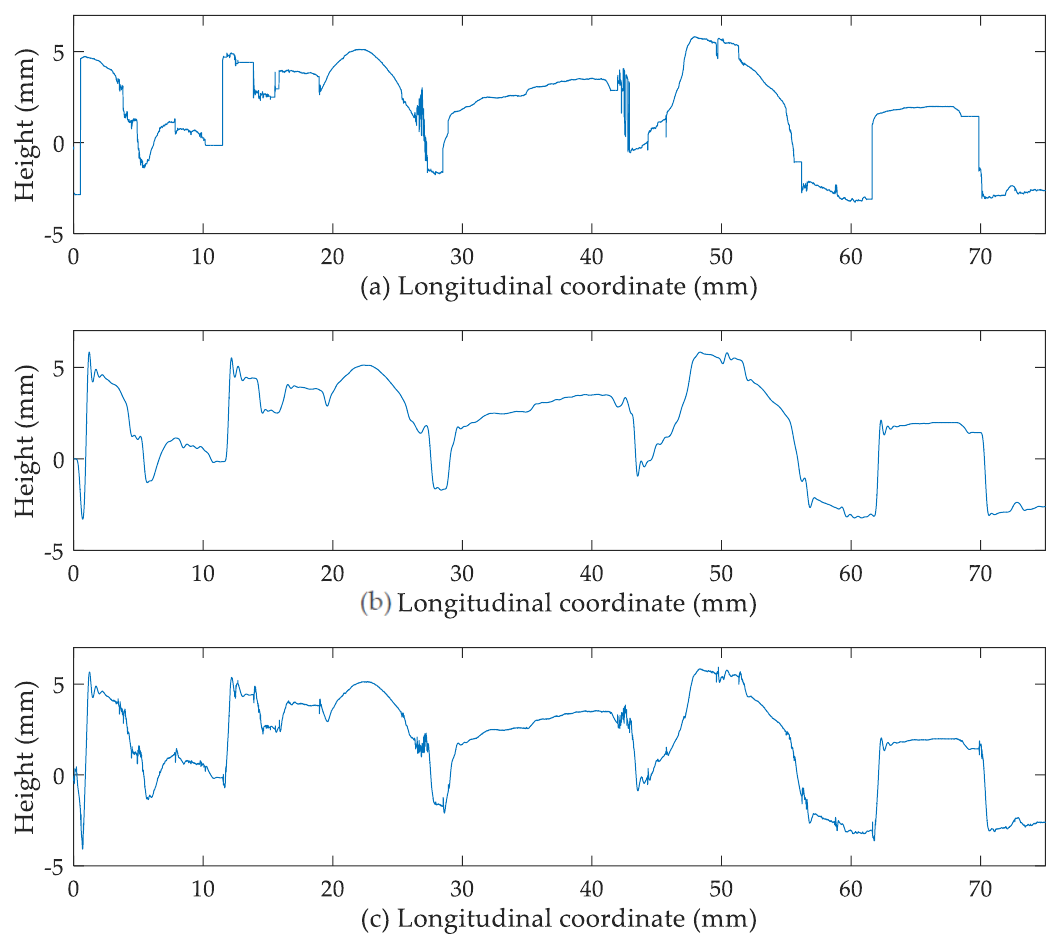
Figure 9. ( a ) Unfiltered profile with dropouts corrected; ( b ) filtered profile only with macro-texture; ( c ) filtered profile (macro-texture micro-texture combined together) without